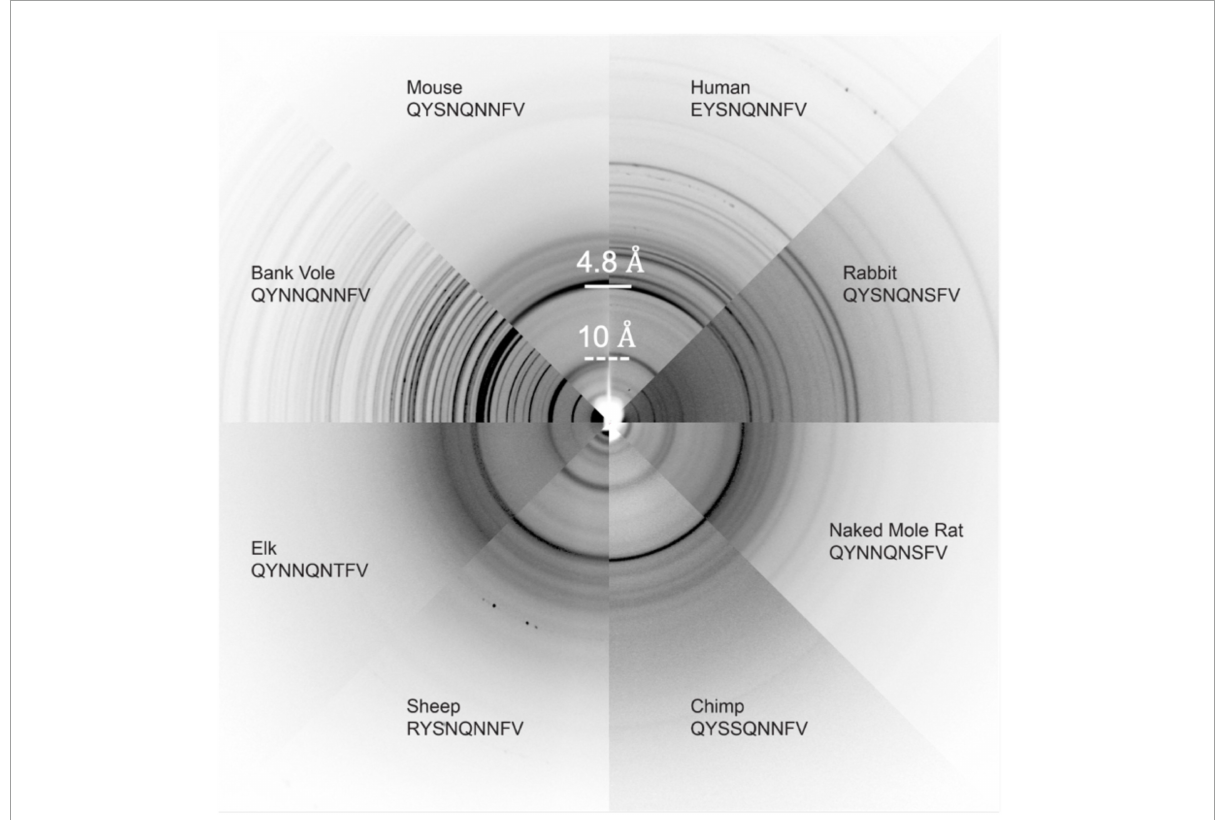
FIGURE7 Fiber Diffraction of β 2 α 2 loop aggregates. Fiber diffraction patterns were collected for crystalline (bank vole, mouse, human, rabbit, and naked mole rat) and fibrillar (chimp, sheep R168 sequence polymorph, and elk) aggregates. All aggregates share ∼ 4.8 and ∼ 10Å reflections indicative of underlying amyloid